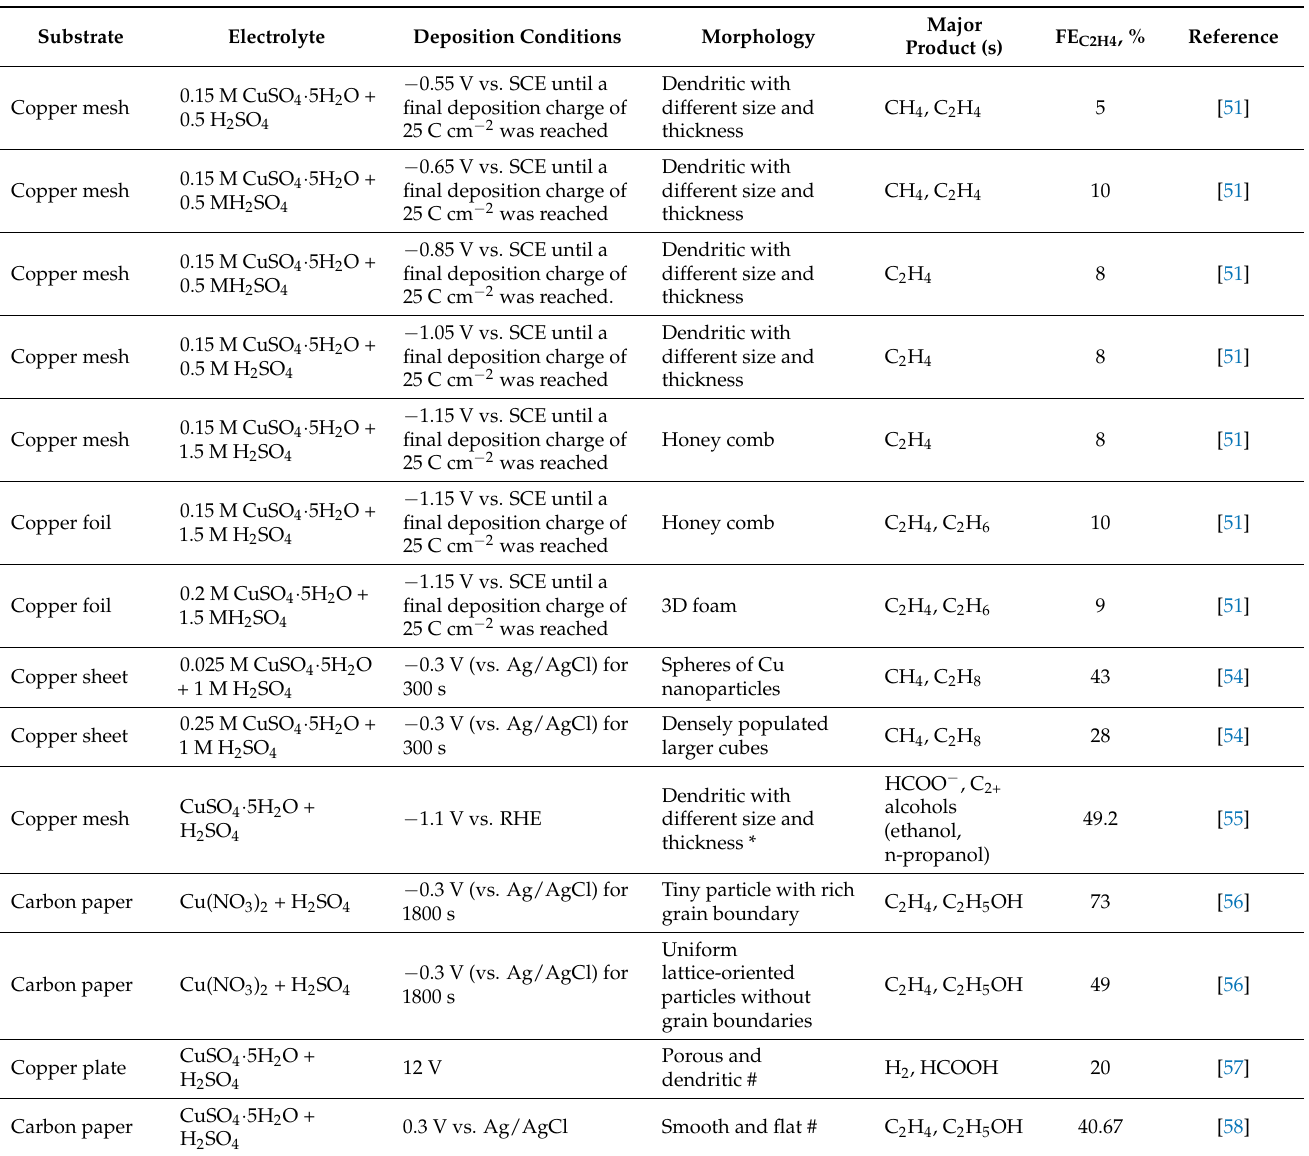
Table 2. Table lists the works that reported on the electrodeposition of copper obtained via potentio- static